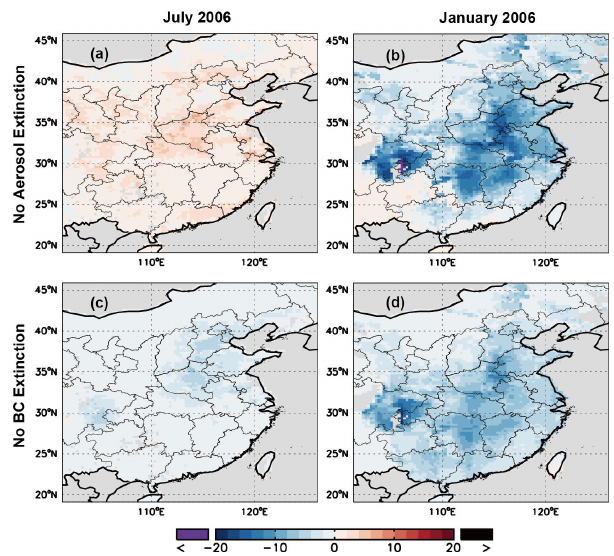
Fig. 11. Spatial distribution of percentage differences between mod- eled NO 2 columns with and without eliminating the scattering and absorption of radiation by all aerosols (a, b) or BC (c, d)